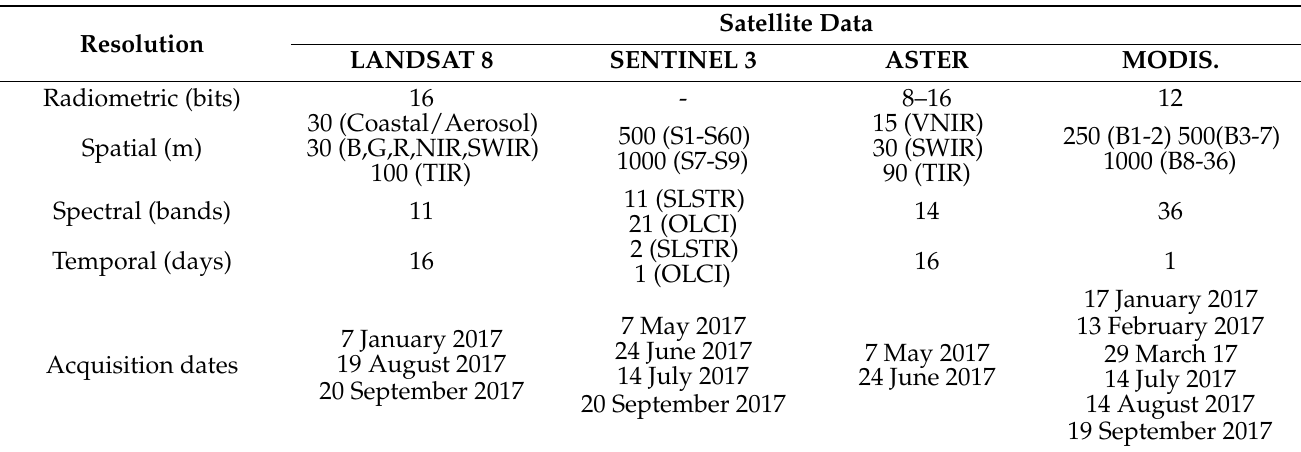
Table 1. Satellite products